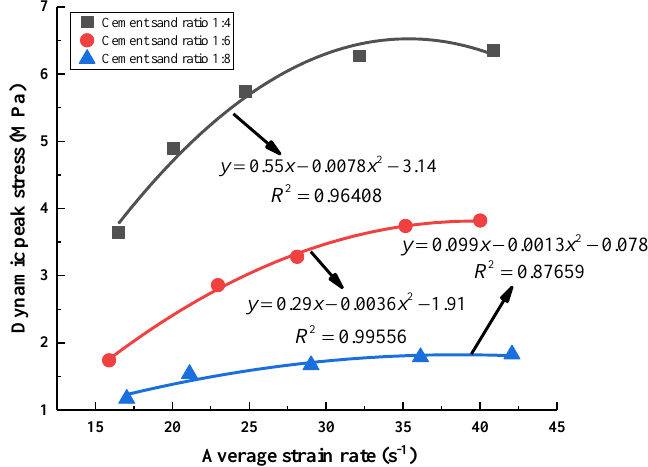
Figure 8. Relationship between average strain rate and dynamic peak stress.